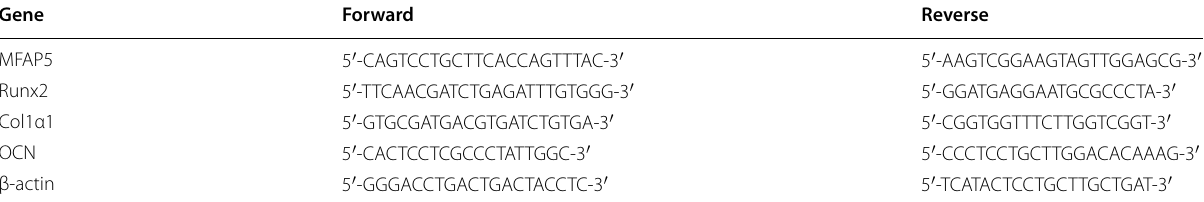
Table 1 The sequences of qRT-PCR primers Gene